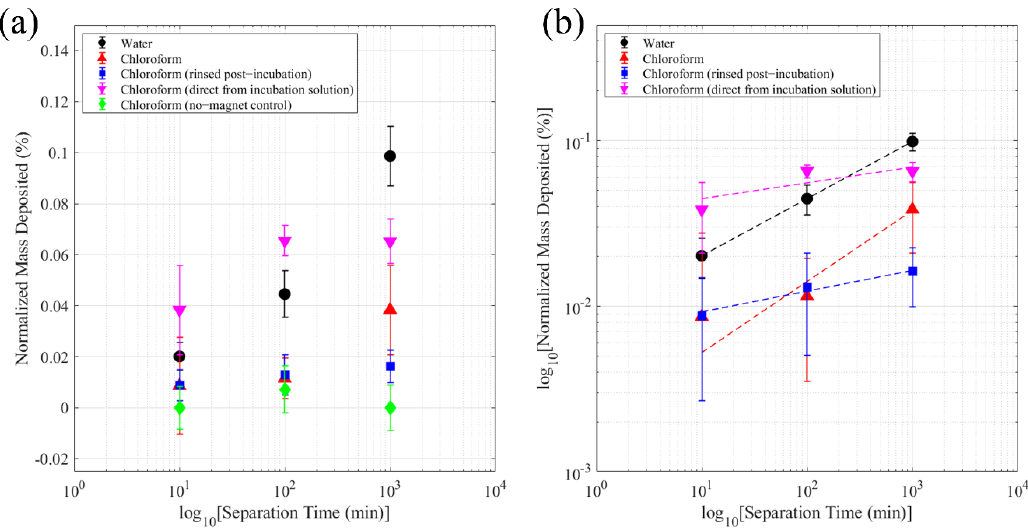
Figure 8. Mass values were normalized by the mass of the clean substrate as follows: normalized mass deposited = (measured mass – substrate mass)/substrate mass × 100% . ( a ) Per- centage mass deposited is presented as a function of time and separation medium. ( b ) Log-log plot of percentage mass deposited versus time. Dashed lines represent power law fits. Table 3. Power law fit parameter values with 95% confidence intervals (CI) and R 2 values. Sample